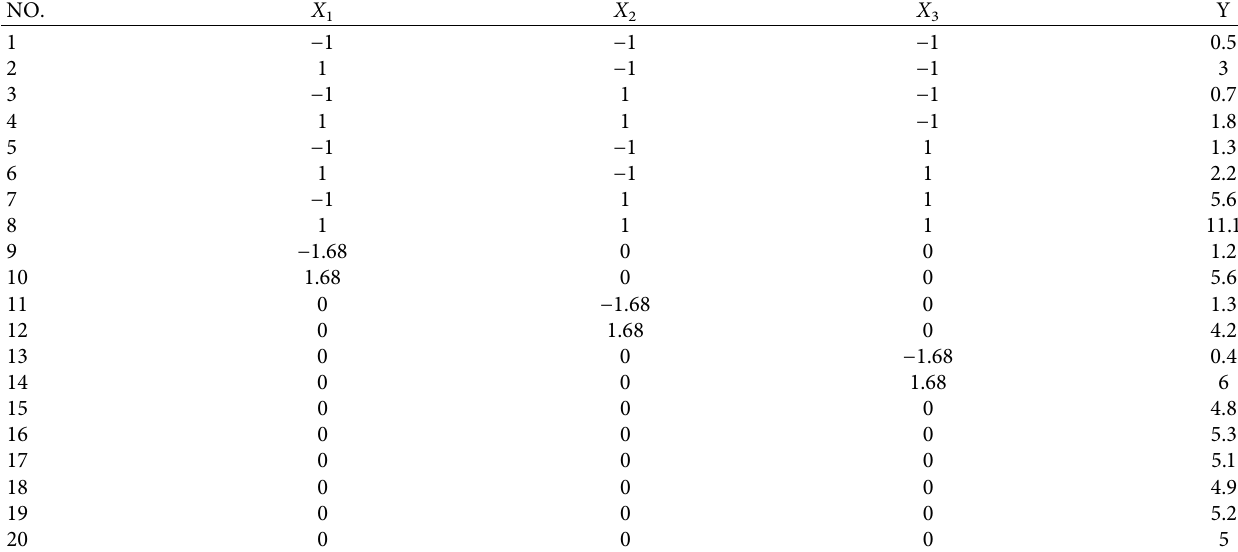
Table 9: Test points and response values of CCD.